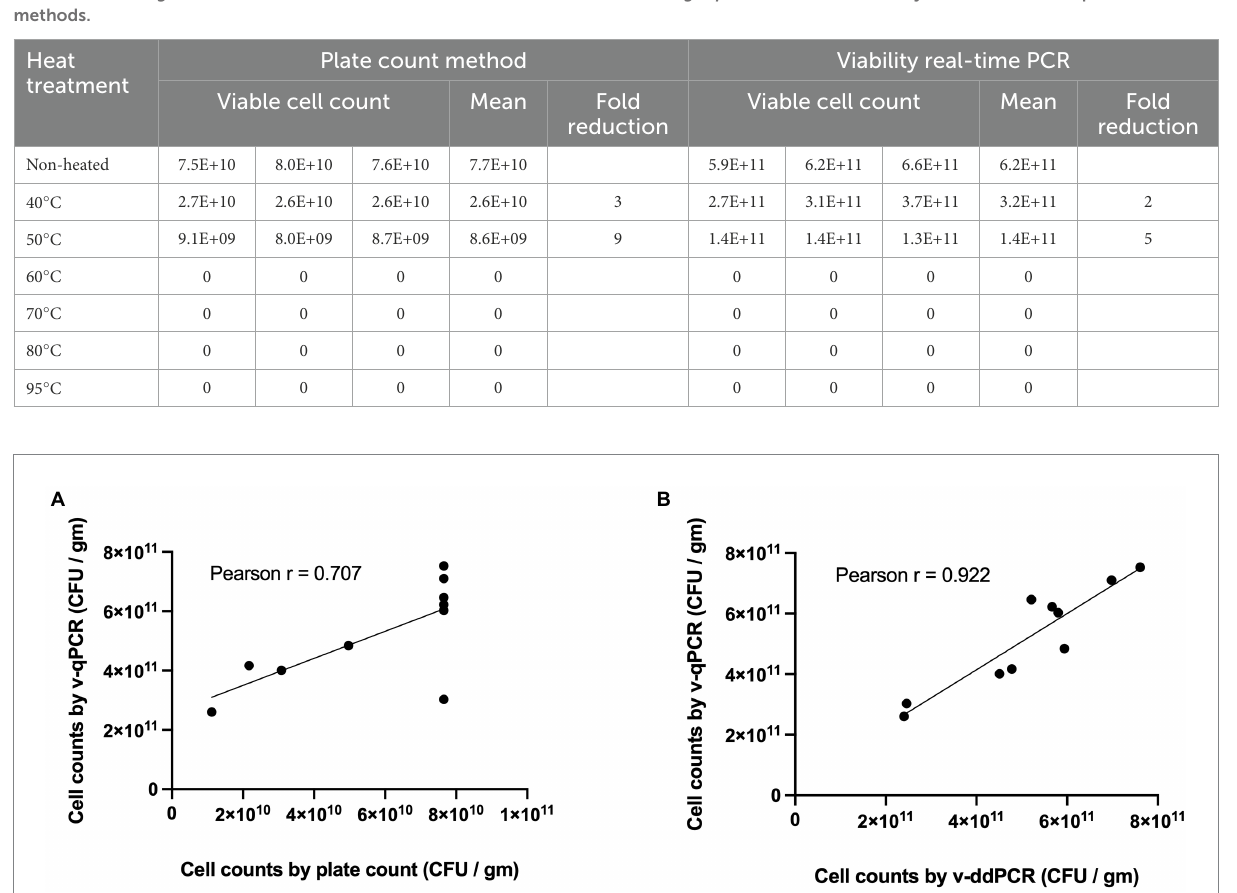
FIGURE 5 Correlation of L. paracasei 8700:2 viability real-time PCR method to plate count and viability droplet digital PCR methods. (A) Correlation between cell counts determined using viability real-time PCR (v-qPCR) and plate count (PC) method (Pearson r = 0.707). (B) Correlation between cell counts determined using viability real-time PCR (v-qPCR) and viability droplet digital PCR (v-ddPCR; Pearson r =